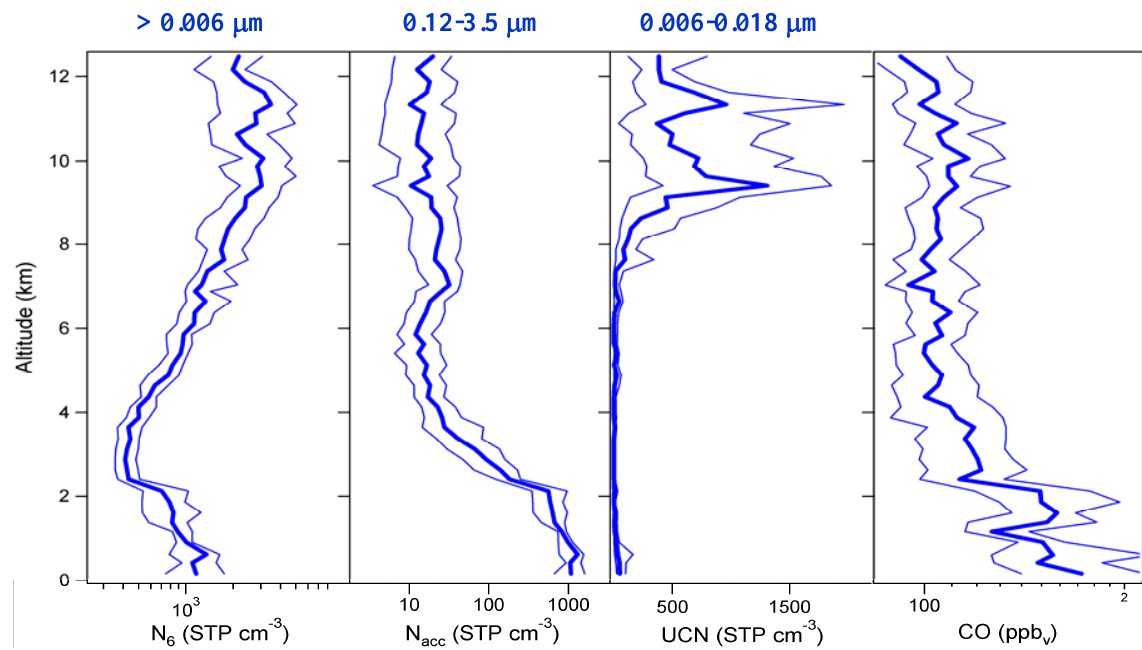
Fig. 24. Vertical profiles of particles of various size classes, along with CO, as measured during flights over the northern Indian Ocean during INDOEX (from de Reus et al., 2001, copyright 2001 by the American Geophysical Union, reproduced with